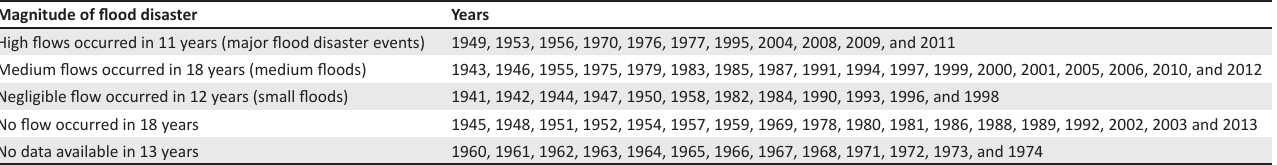
TABLE 1: Reported flood events in the Cuvelai basin for the last 73 years from 1941 to 2013. Magnitude of flood disaster